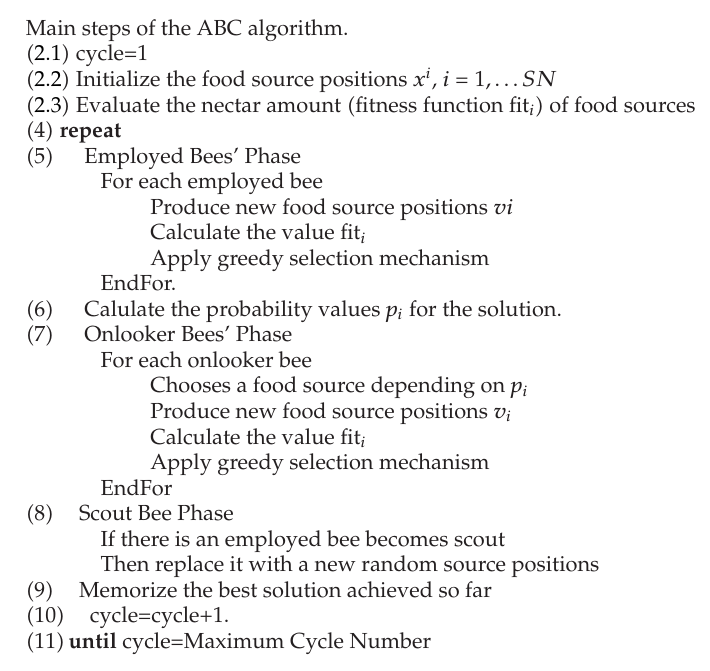
Algorithm 1: Pseudocode for ABC